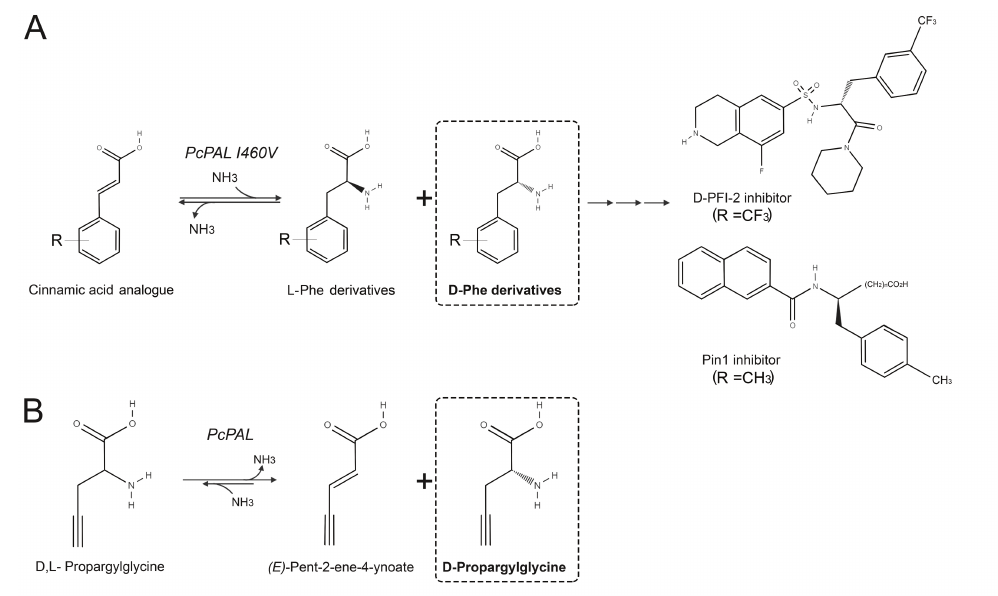
Figure 6. The application of PcPAL in D-AAs synthesis. ( A ) Resolution of substituted D-phenylglycines by the I460V PcPAL variant [39]. ( B ) Preparation of enantiopure D-propargylglycine by enantioselective deamination of L-propargylglycine catalyzed by PcPAL immobilized on magnetic nanoparticles